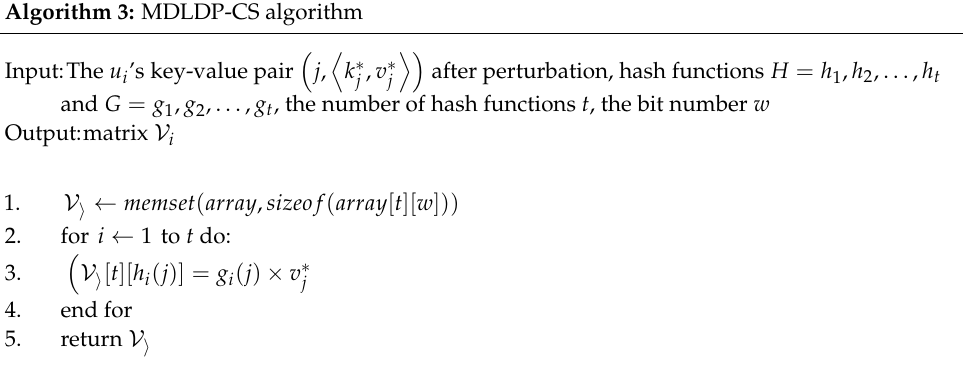
Algorithm 3: MDLDP-CS